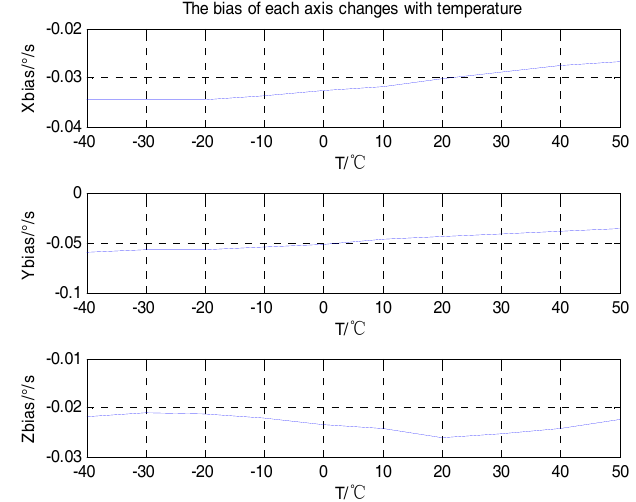
Figure 6. Bias varies with temperature.